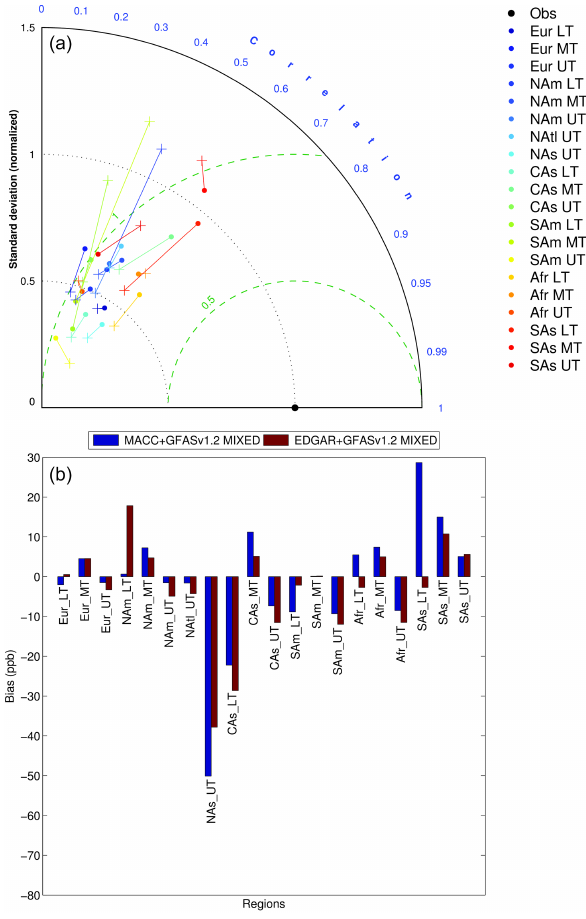
Figure 12. Comparison of the SOFT-IO anthropogenic emission in- fluence between 2002 and 2008. (a) Taylor diagrams are obtained for the different regions and in the three vertical layers (LT, MT and UT) using MACCity (dots) and EDGARv4.2 (crosses) with GFAS (lines represent connections between the two inventories). (b) Mean biases between the modeled (blue for MACCity + GFAS; brown for EDGARv4.2 + GFAS) and observed CO anomalies. The MIXED methodology is used for fire vertical